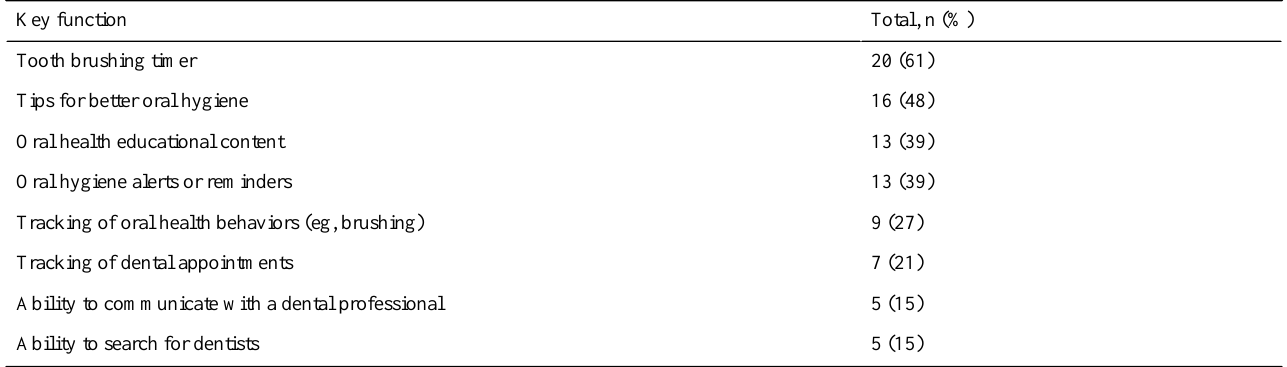
Table 3. Summary of key app functions.